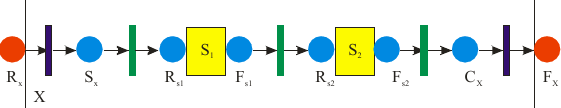
Fig.2. The service net for BPEL sequence pattern ③ SS ⊗ represents BPEL's flow pattern, which 21 represents a flow that provides the capability for the parallel execution and synchronization for a more Web Fig.5. The service net for BPEL pick pattern services, such as Web services S parallel by S . Fig.3 1 2 Here, the pick activity waits for the occurrence of shows how this can be mapped into a service net. exactly one event from a set of onMessage and onAlarm events, and then executes the activity associated with that event, which contains a number of. In Fig.5, for the labeled E or E , means the corresponding events. As 1 2 soon as the event has occurred, the pick can start the corresponding and associate service. ⑤ S λ represents BPEL's while pattern, which supports Fig.3. The service net for BPEL flow pattern iterative performance of a specified iterative activity Here, a flow activity contains a number of links and a and is performed until the given boolean while number of services, and all contained internal services condition no longer holds true. Fig.6 shows how this are executed in parallel in the same time. can be mapped onto a service